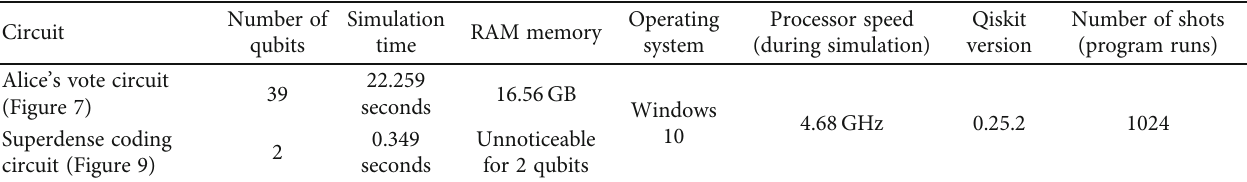
Table 2: Main results for the presented